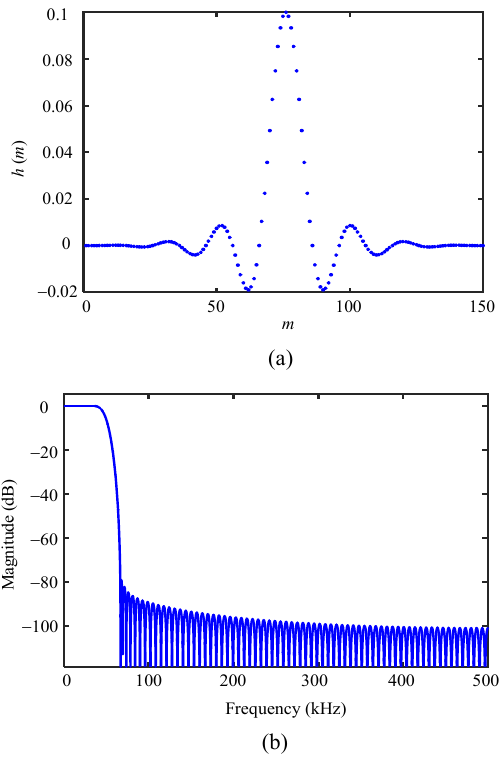
Fig. 9 Choice of pulse broadening threshold and the effect of the first-order lag pulse broadening filter: (a) the distribution of pulse broadening and (b) results of FBG interrogation after using the first-order lag pulse broadening filter.